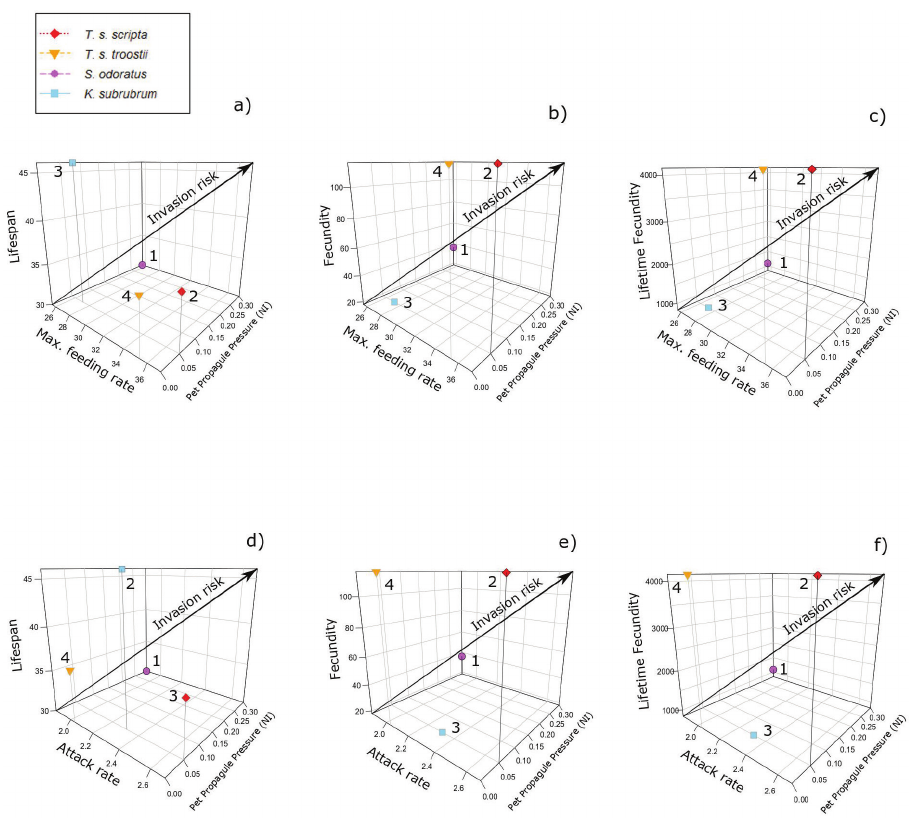
Figure 4. Triplots showing Relative Invasion Risk of T. s. scripta , T. s. troostii , S. odoratus and K. subru- brum in a Northern Irish context. Invasion Risk calculated as a product of maximum feeding rate and Pet Propagule Pressure (PPP) with lifespan ( a ), with fecundity ( b ) and with lifetime fecundity ( c ); then attack rate and PPP with lifespan ( d ), with fecundity ( e ) and with lifetime fecundity ( f ). PPP for each species calculated by surveying 20 local pet shops and determining proportions of each species sold. Invasion Risk increases from bottom left to top right of each plot, with species ranked